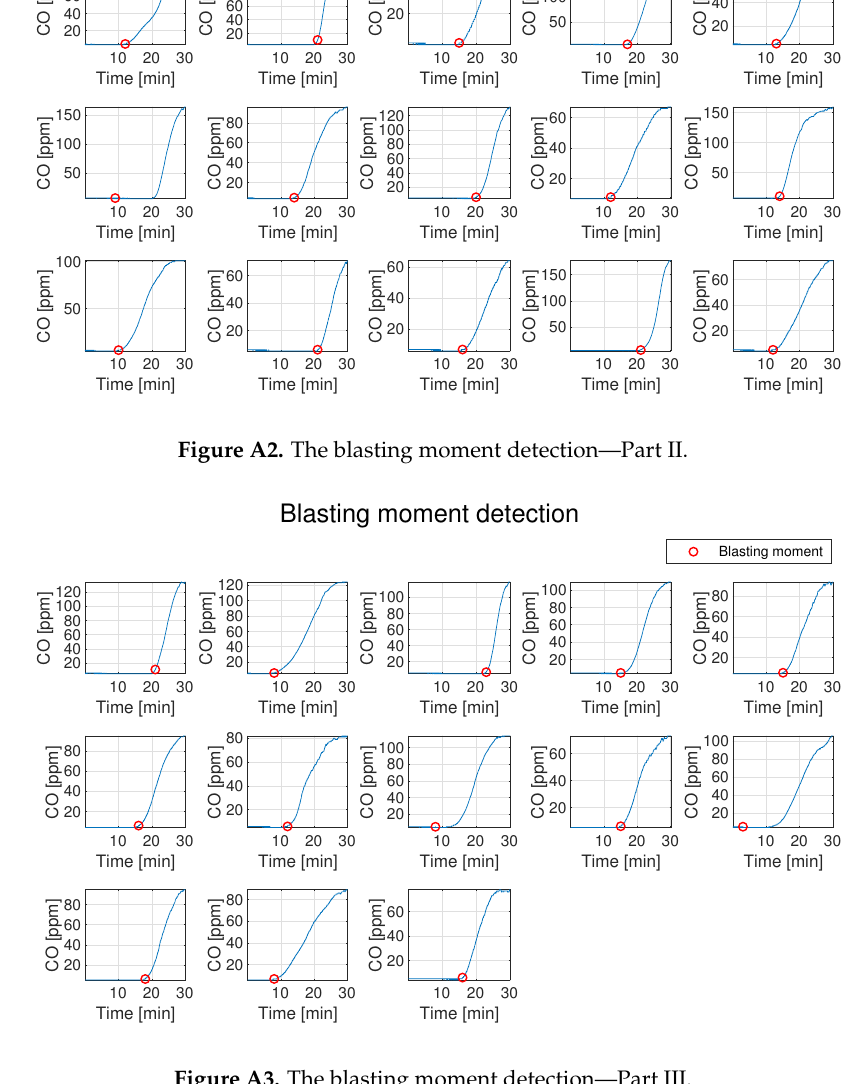
Figure A3. The blasting moment detection—Part